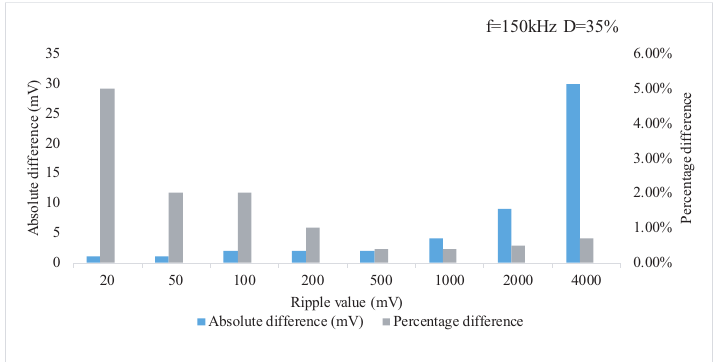
Figure 10. The measurement differences for different amplitudes.